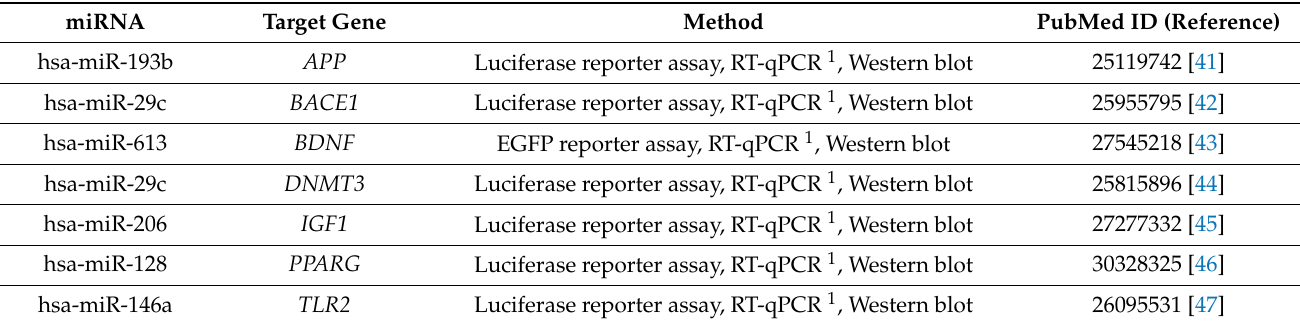
Table 2. Experimentally confirmed MTI prioritized as very strong AD-related